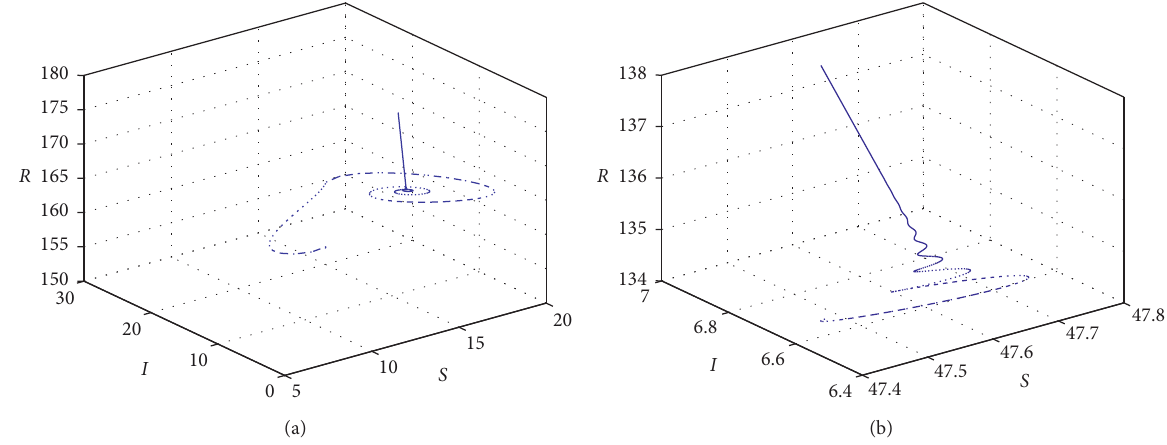
( τ ) > 1 and q 2 ( τ ) ≥ 3 q ( τ ) : (a) Θ 2 � − 1.6804; 0 1 2